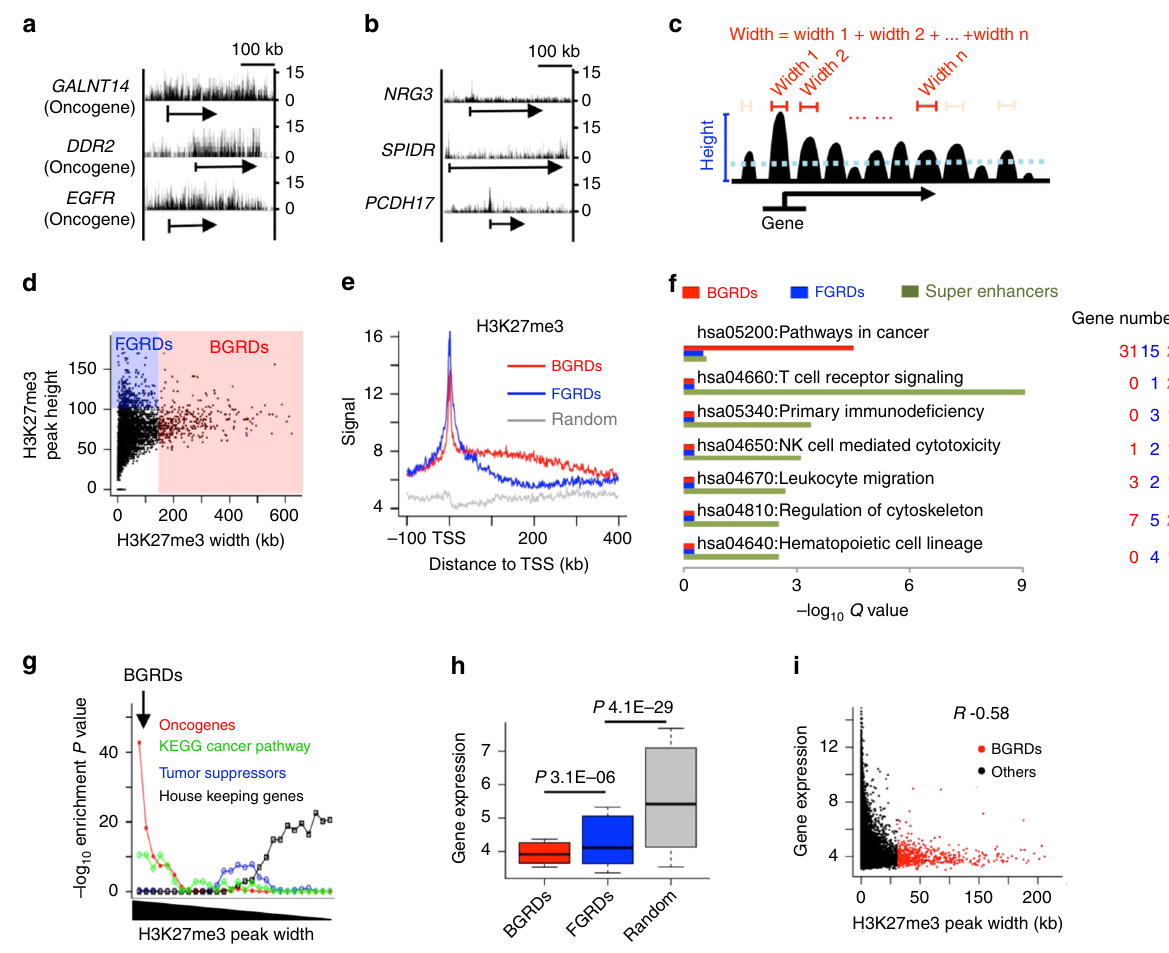
Fig. 1 Oncogenes reside in BGRDs on chromatin in normal CD4 + T cell. a , b H3K27me3 ChIP-Seq signal in three BGRDs a and three FGRDs b . Arrows indicate gene loci associated with these repressive domains. Gene names were indicated at the left side. Y -axis scale at the right side indicates ChIP-Seq signal strength. c Cartoon to show the de fi nition of width and height for H3K27me3 ChIP-Seq enrichment peaks on a gene. d Height plotted against width of H3K27me3 ChIP-Seq enrichment peaks at each gene. Red and blue areas indicate peaks that were de fi ned to be BGRDs and FGRDs, respectively. e Average ChIP-Seq signal value for H3K27me3 plotted around TSS associated with each category of repressive domains. f Enrichment level of KEGG pathways in genes associated with BGRDs, FGRDs, or super enhancers. Q value indicates Benjamini-adjusted P value. g Enrichment level of each gene category plotted against H3K27me3 peak width. Genes were ranked by H3K27me3 width and divided into groups that each contain 1500 genes, with two neighboring groups in the rank has 500 genes in common. A dot in each curve indicates the enrichment level ( Y -axis) of one of these groups ( X -axis) in the oncogenes, KEGG cancer pathway genes, tumor suppressor genes, or housekeeping genes as indicated by the color legends. h Boxplot to show microarray expression values ( Y -axis) of genes associated with each category of repressive domains ( Y -axis), n = 500 for each category. Box plots: center line is median, boxes show fi rst and third quartiles, whiskers extend to the most extreme data points that are no more than 1.5-fold of the interquartile range from the box. i Microarray expression value of each gene plotted against width of the gene ’ s H3K27me3 enrichment peak, with Spearman correlation coef fi cients indicated on top. P values determined by one tail Fisher ’ s exact test g or one tail Wilcoxon test h . Source data are provided as a Source Data fi